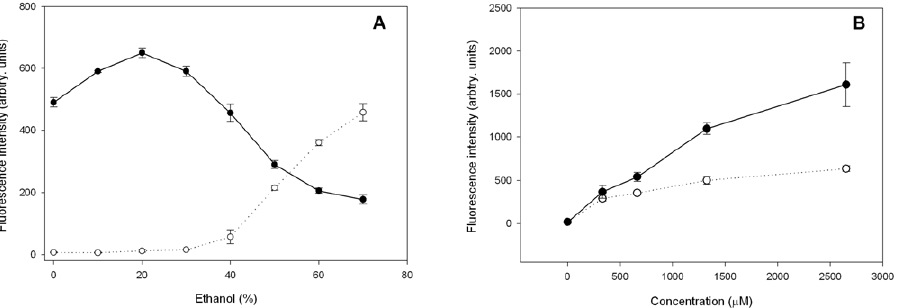
Figure 8. Encapsulation studies with 5(6)-Carboxyfluorescein. (A) 5(6)-Carboxyfluorescein loaded peptide vesicles were prepared in different ethanol concentrations and separated over 30 kDa MWCO filters. Fluorescence intensities of the filtrate (open circles) and retentate (solid circles) were collected after separation and show that encapsulation efficiency decreases with increasing ethanol concentration. (B) h 9 h 5 -vesicles prepared with the dye present during vesicle formation (solid circles) or added after the vesicles are formed (open circles). Each data point represents an average of 3 separate experiments performed on different days. Data points are connected with straight lines through their midpoints.